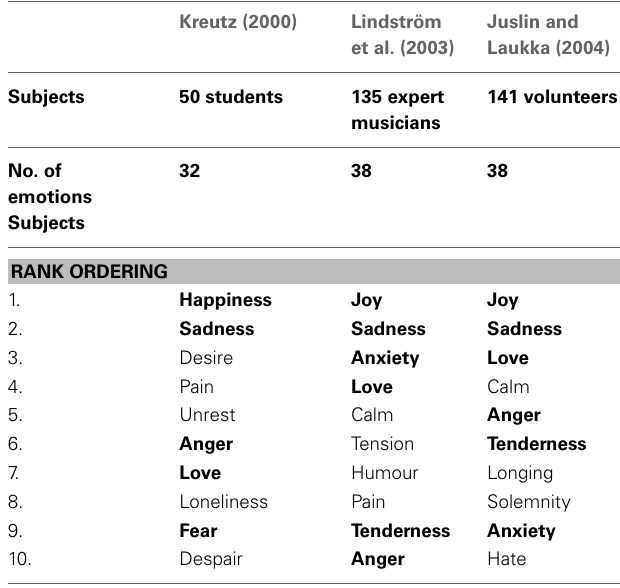
Only the ten most highly rated emotions in each study have been included in the Table. Those emotion categories that correspond to the basic emotions are set in bold text. (Anxiety belongs to the “fear family,” and tenderness to the “love” family, see, e.g., Shaver et al., 1987.) The original lists of emotion terms con- tained both “basic” and “complex” emotions, as well as some terms commonly emphasized in musical contexts (e.g., solemnity).